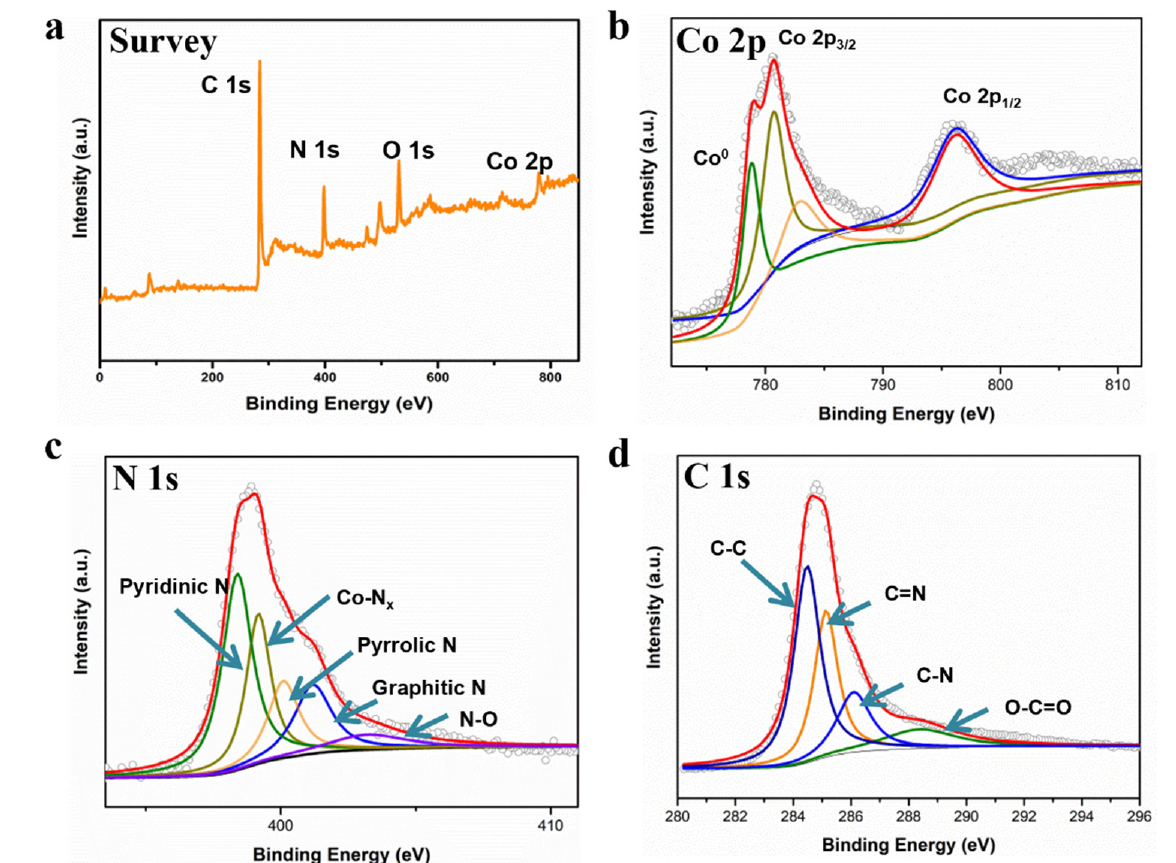
Figure 3. ( a ) XPS survey of gl-CNTs/Co@N-C; the experimental and fitted high-resolution XPS spectra of ( b ) Co 2p, ( c ) N 1s, and ( d ) C 1s for gl-CNTs/Co@N-C.